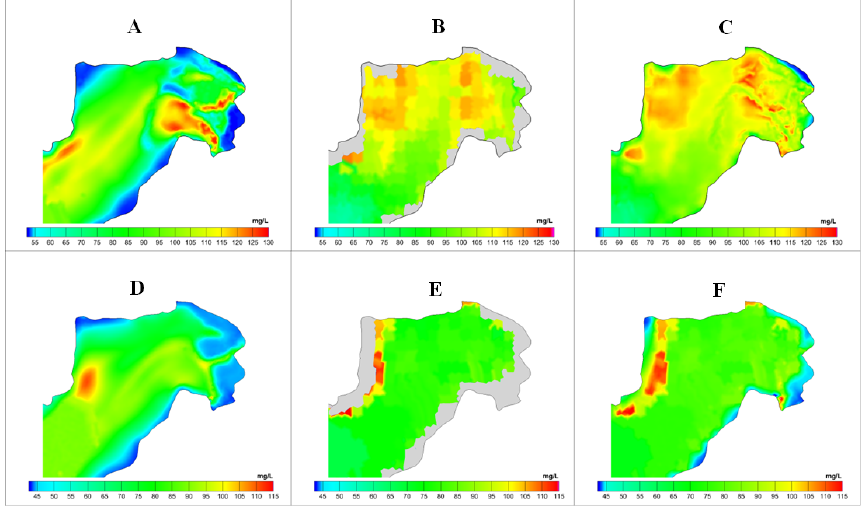
Figure 6. Comparison of the sediment spatial distribution from those retrieved from ( A ) model results (Model); ( B ) remote sensing images (RS); and ( C ) OI results at the first assimilation time (13:30, on 17 October) and from ( D ) model results (Model); ( E ) remote sensing images (RS); and ( F ) OI results at the second assimilation time (13:30, on 18 October).